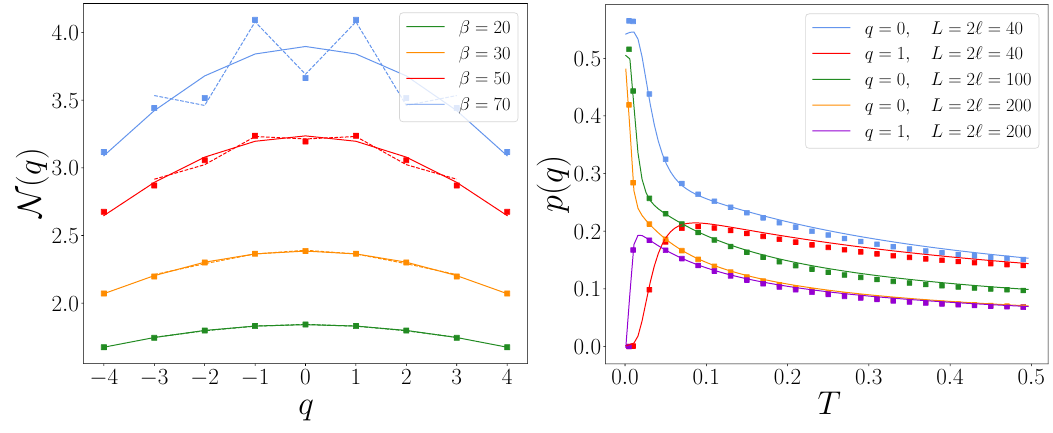
Figure 7: Left panel: The imbalance-resolved negativity as a function of q in a bipar- = 40, the total system sizes is also fixed, tite geometry. The subsystem size is fixed, (cid:96) 1 L = 200, while T is varied. The coloured full lines represent Eq. (137) while the dashed ones represent Eq. (136) in the replica limit. Right panel: The probability of finding q as outcome of a measurement of ˆ Q . As the state becomes pure (i.e. T → 0), p ( q ) → 0 for odd q , as explained in Sec. 2.3. The full lines correspond to the Fourier transforms of the charged probability in (119) without saddle-point